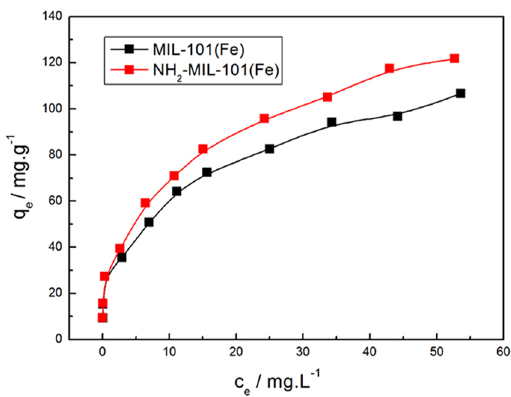
Figure 10. Adsorption isotherms of phosphate on Fe-based MIL-MOFs ( Adsorbents, 12 mg; NaH 2 PO 4